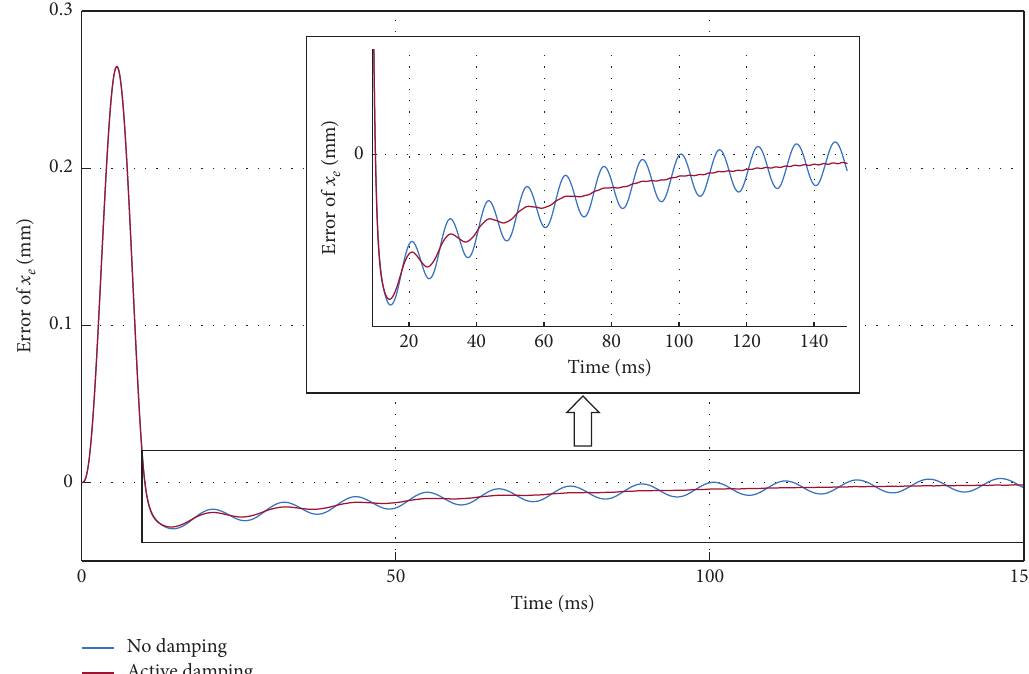
Figure 6: End effector’s tracking error in X -direction between desired and actual path (blue line refers to the undamped system where red line refers to active PZT damping).